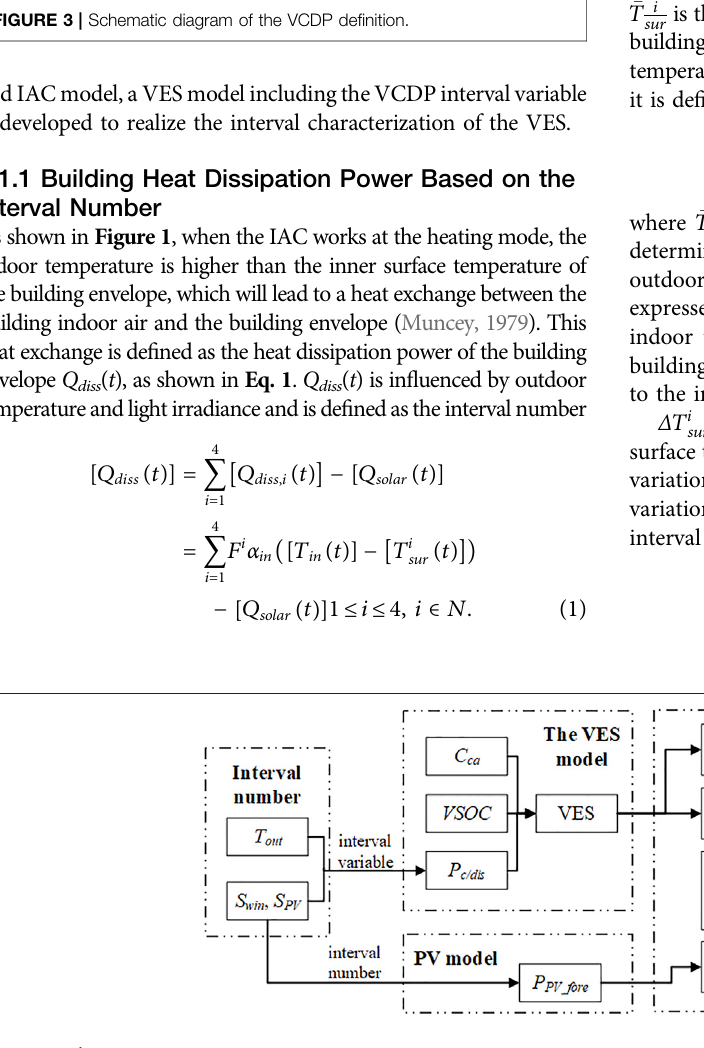
Frontiers in Energy Research |